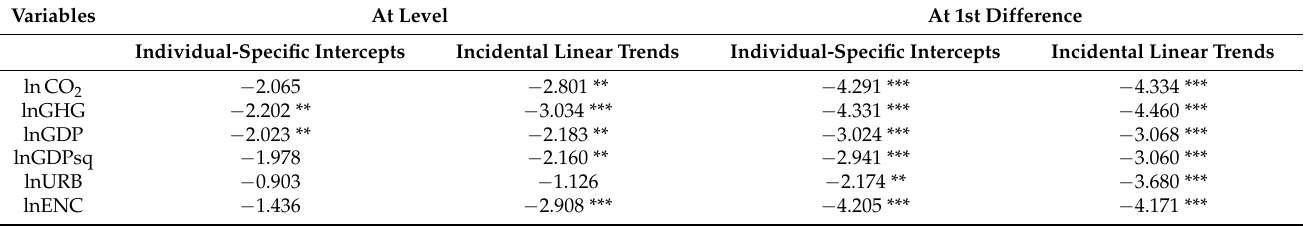
Table 5. Pesaran panel unit root test in the presence of cross-section dependence. Variables At Level At 1st